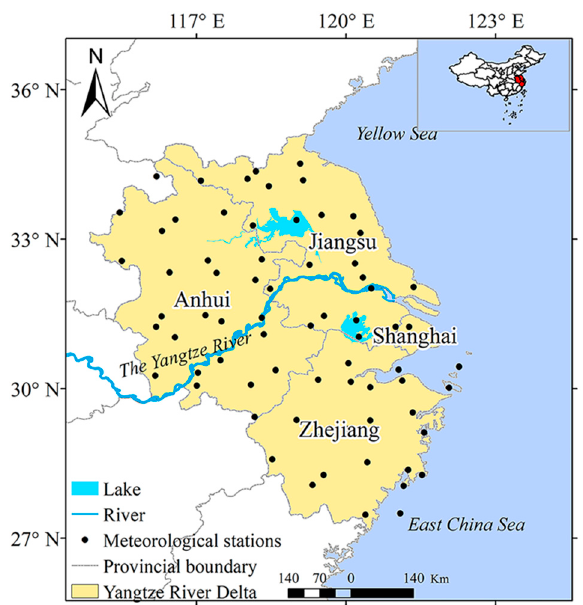
Figure 1. The study area and spatial distribution of 68 meteorological stations.